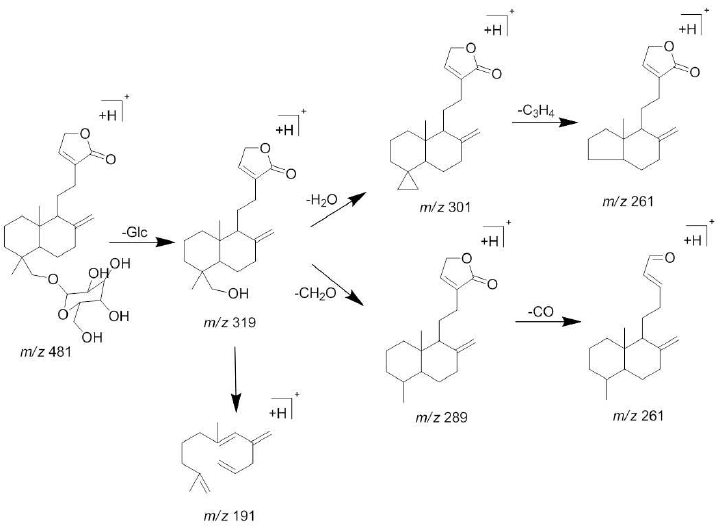
Figure 6. The proposed fragmentations pattern of neoandrographolide ( 3 ).